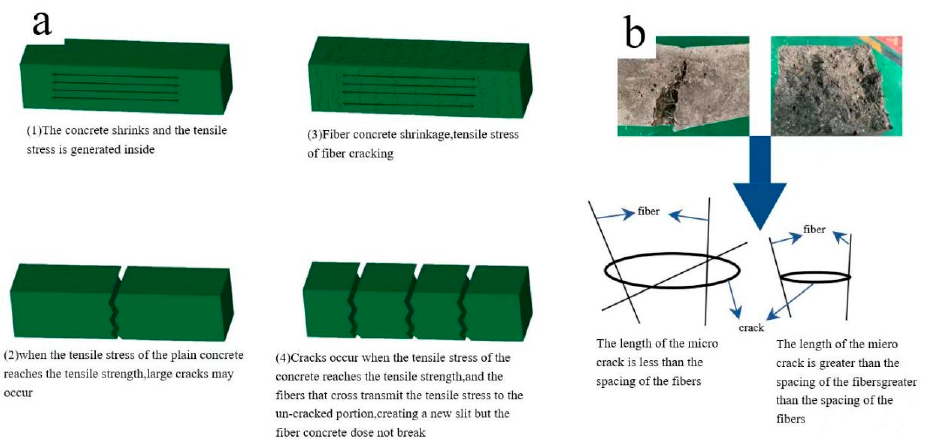
Figure 3. Crack resistance mechanism of steel fiber. ( a ) Crack resistance mechanism of steel fiber when concrete is under tension. ( b ) Crack resistance mechanism of steel fiber with different lengths of micro-cracks).